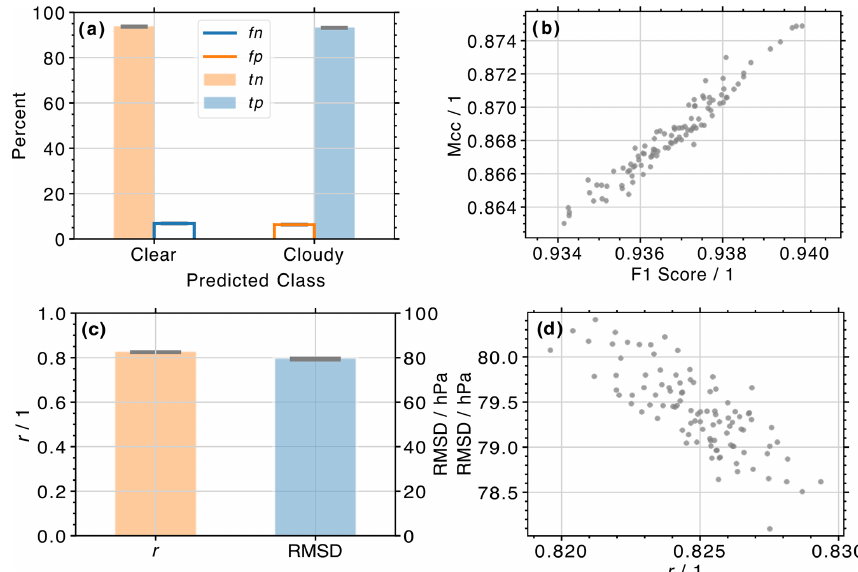
Figure 4. (a) Histograms of cloud classifications from the ANN algorithm for 100 random combinations of training and validation data sets. Orange and blue shading depicts the percent of correctly predicted clear (i.e., true negatives, tn) and cloudy (i.e., true positives, tp) labels for actually observed clear and cloudy profiles, respectively. Orange and blue lines depict the percent of falsely predicted cloudy (i.e., false positives, fp) and clear (i.e., false negatives, fn) labels for actually observed clear and cloudy profiles, respectively. The vertical extent of the gray horizontal bars on top of each histogram indicates the standard deviation derived from all 100 predictions (the horizontal extent is arbitrary). (b) Scatter plot of Matthews correlation coefficient (Mcc) and F1 score for the same 100 random combinations of training and validation data sets shown in (a) . (c) Similar to (a) but showing histograms of derived Pearson product-moment correlation coefficient ( r ) and root mean square deviation (RMSD) from the ANN cloud top pressure algorithm. (d) Similar to (b) but showing the relationship between r and